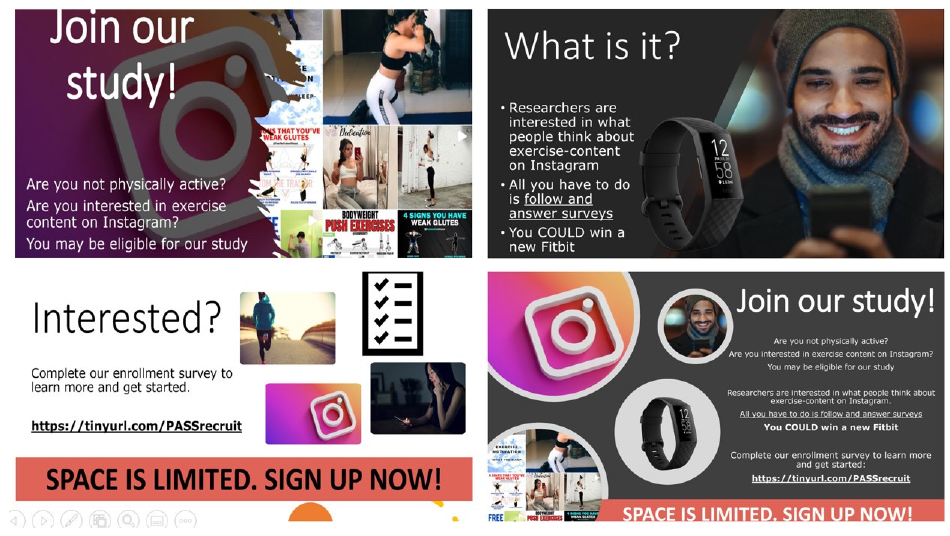
Figure 1. Paid social media ads.